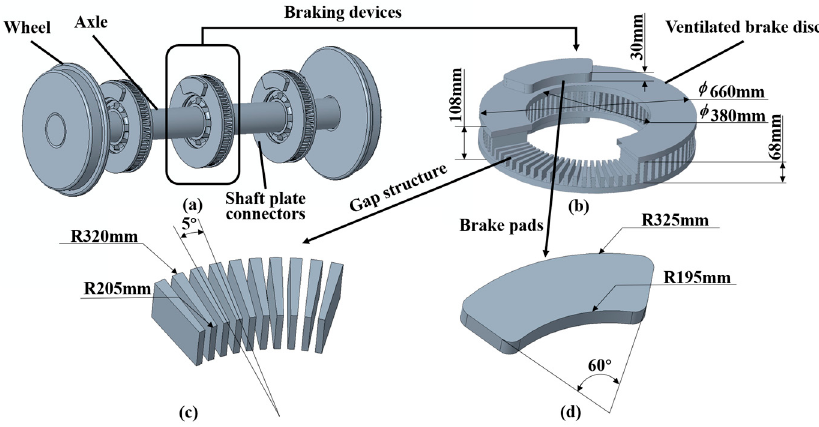
Figure 3. High-speed train disc brake assembly diagram. ( a ) Axle-disc connection assembly; ( b ) Ventilated brake disc; ( c ) Gap structure of ventilated brake discs; ( d ) Brake pad.